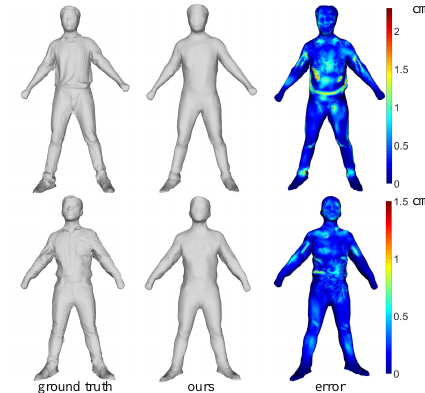
Figure 12. The watertight reconstruction of different people.